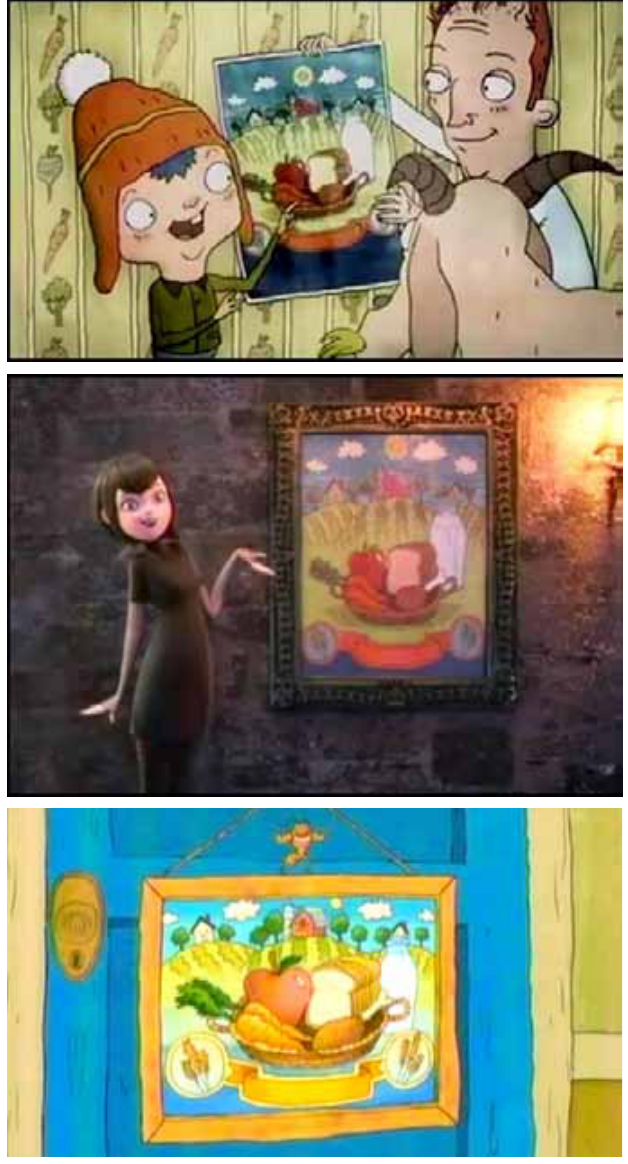
Source: TV advertising content analysis (2009,